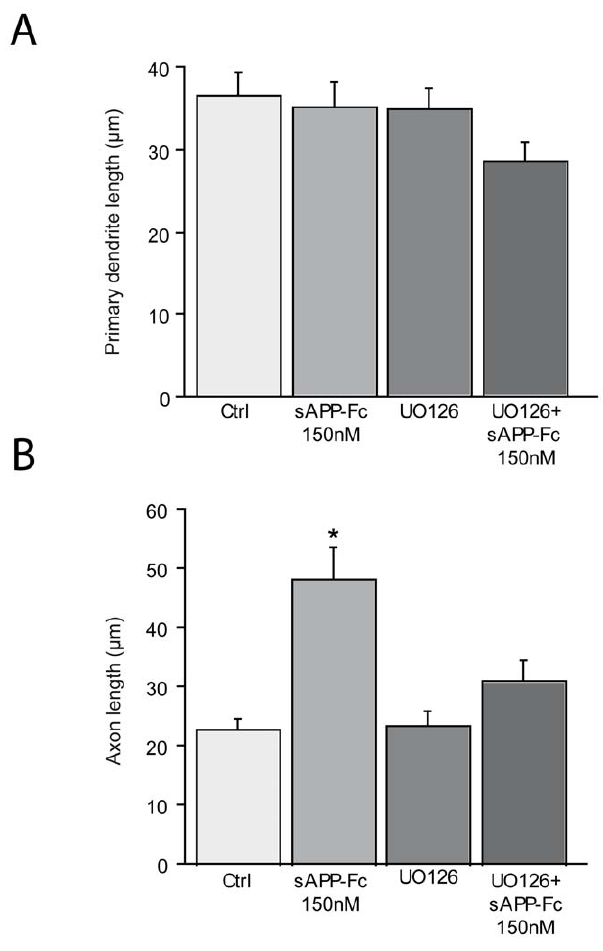
Figure 3. UO126 inhibits changes in neuronal morphology after 150 nM sAPP-Fc added to 1DIV neurons. UO126 was added to neurons after 1DIV 1 hour before the addition of 150 nM sAPP-Fc. Morphometric analysis was performed 48 hours later. ( A ) UO126 does not induce any change in primary dendrite length by itself nor in combination with sAPP-Fc (control (Ctrl) vs sAPP-Fc: NS; control vs UO126: NS; control vs UO126 + sAPP-Fc: NS). ( B ) UO126 1 hour before the addition of sAPP-Fc significantly reduces the growth of axons induced by sAPP-Fc (control vs sAPP-Fc: p , 0.0001; control vs UO126: NS; control vs UO126 + sAPP-Fc: NS). The data presented in A and B